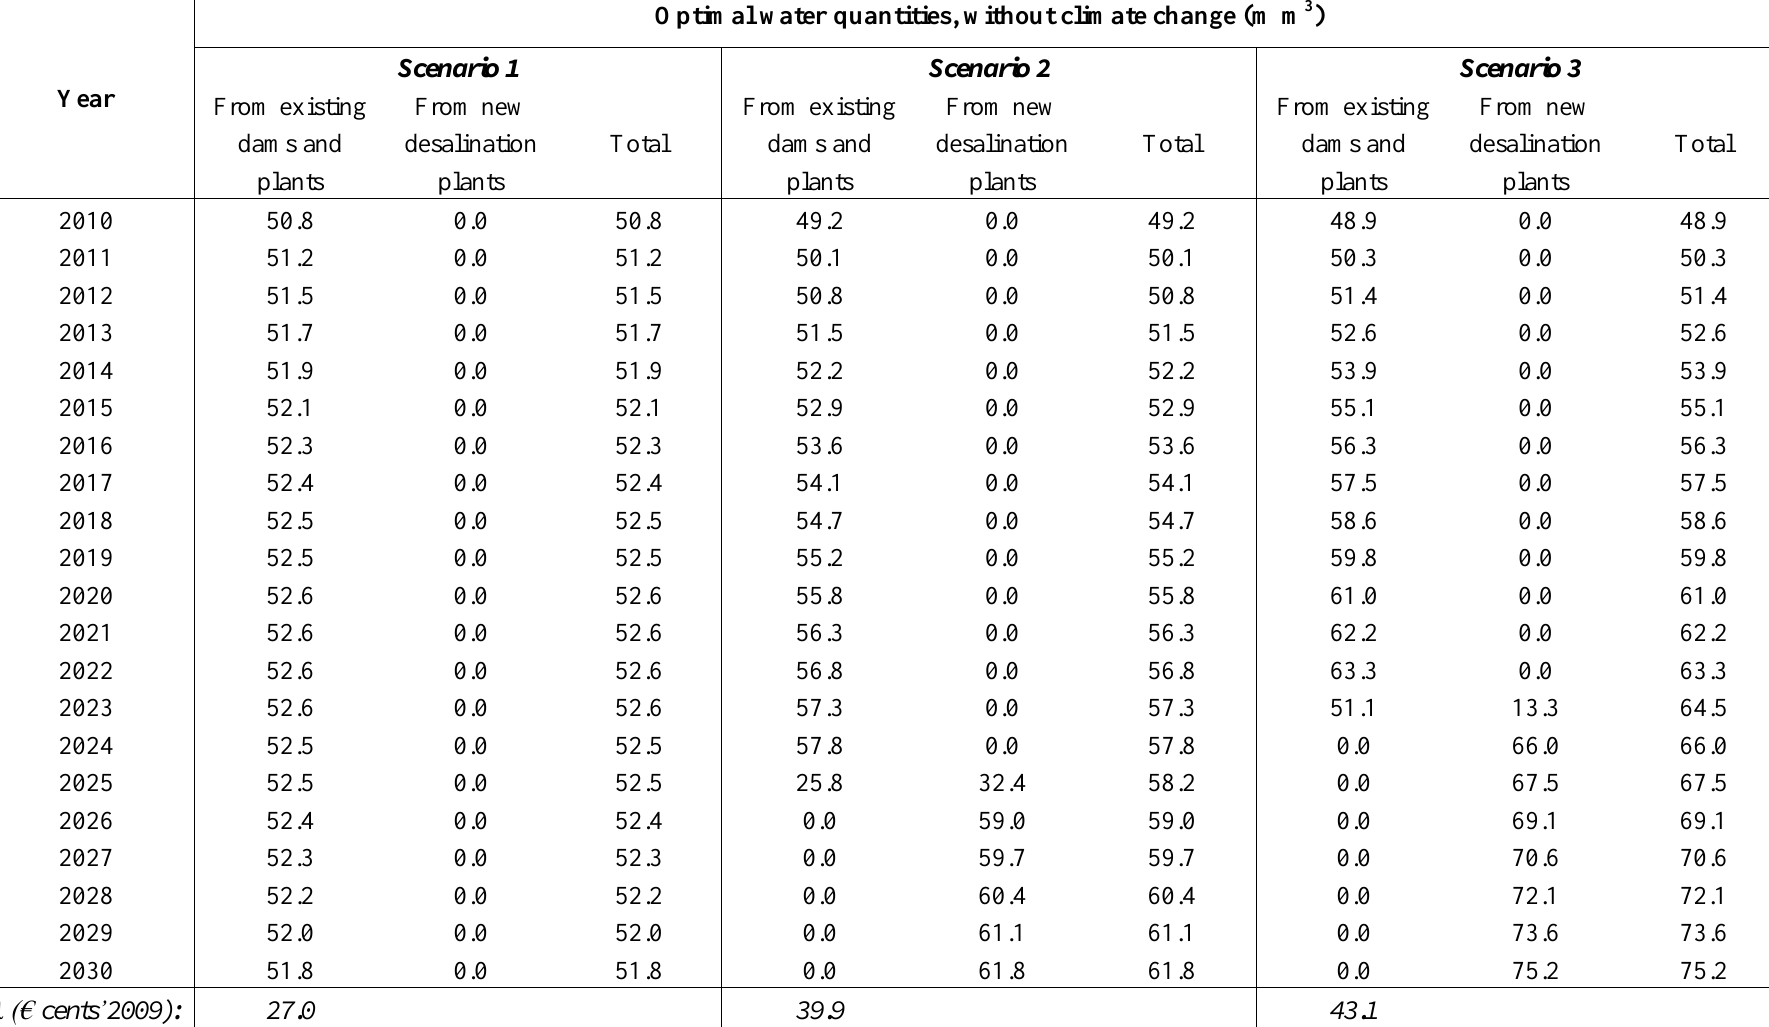
Table 6. Marginal scarcity price ( λ ) and optimal annual water quantities to be supplied by existing sources or new desalination plants in